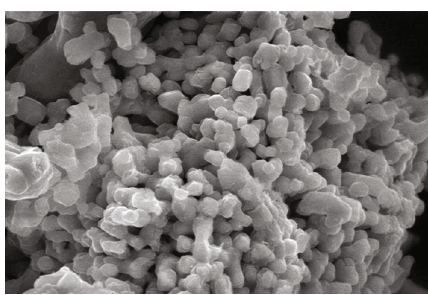
Figure 7: SEM of biodiesel catalyst